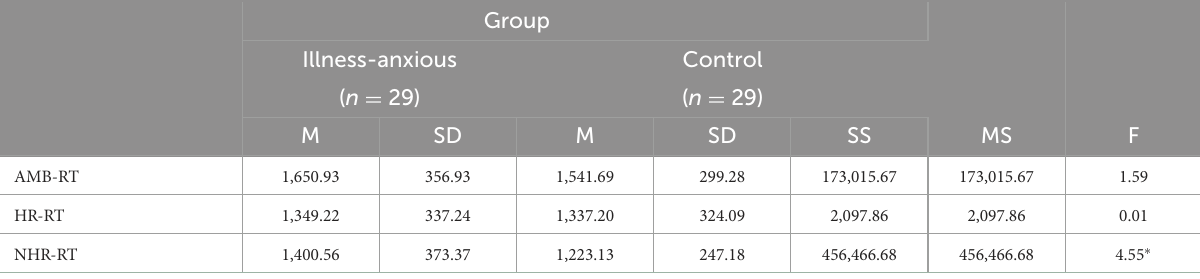
TABLE 4 Results of descriptive statistics and MANOVA for between-group differences in Reaction Time to AMB, HR, and NHR scenarios.